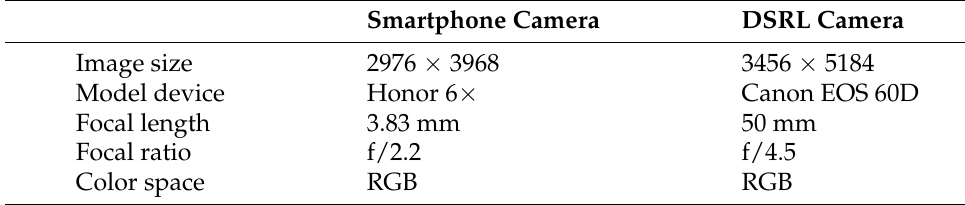
Table 2. Devices configurations.